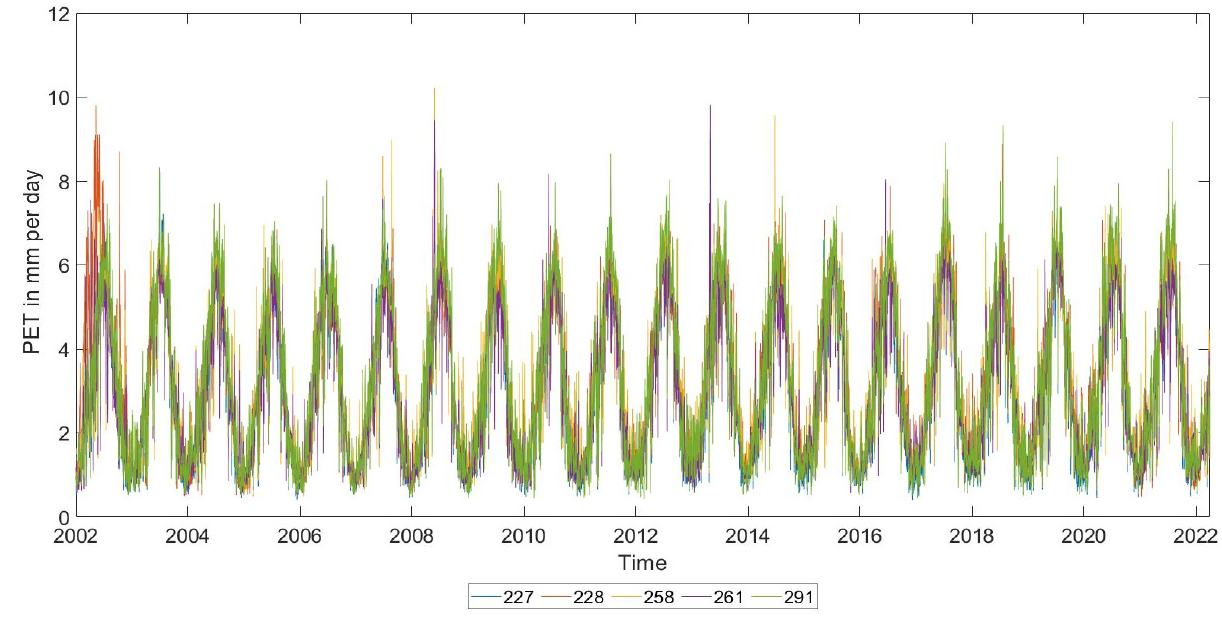
Figure 2. Time series for five meteorological stations confirmed an annual trend.